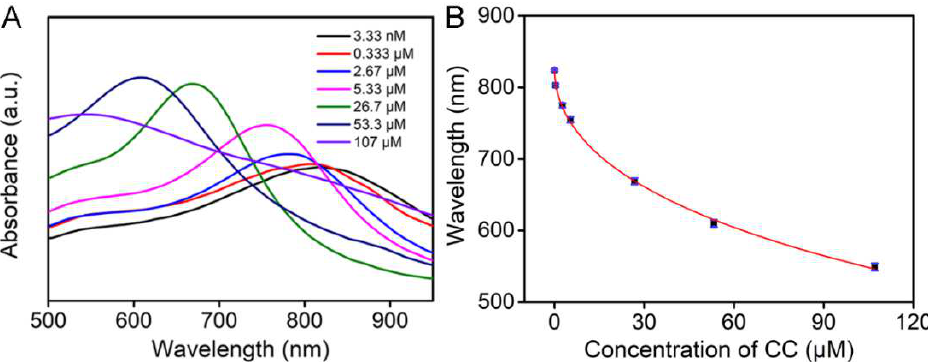
Figure 4. ( A ) UV−vis absorption spectra with different concentrations of CC. ( B ) Standard curve for CC detection based on target-mediated plasmonic colorimetric sensing. The error bars represent the standard deviation of three measurements.